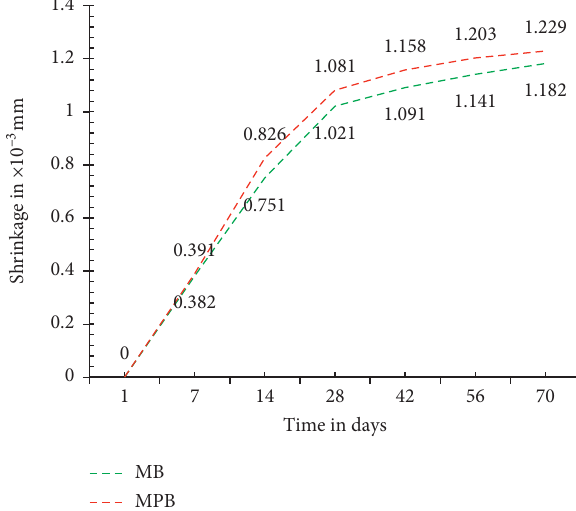
Figure 2: Drying shrinkage of MB and MPB samples.